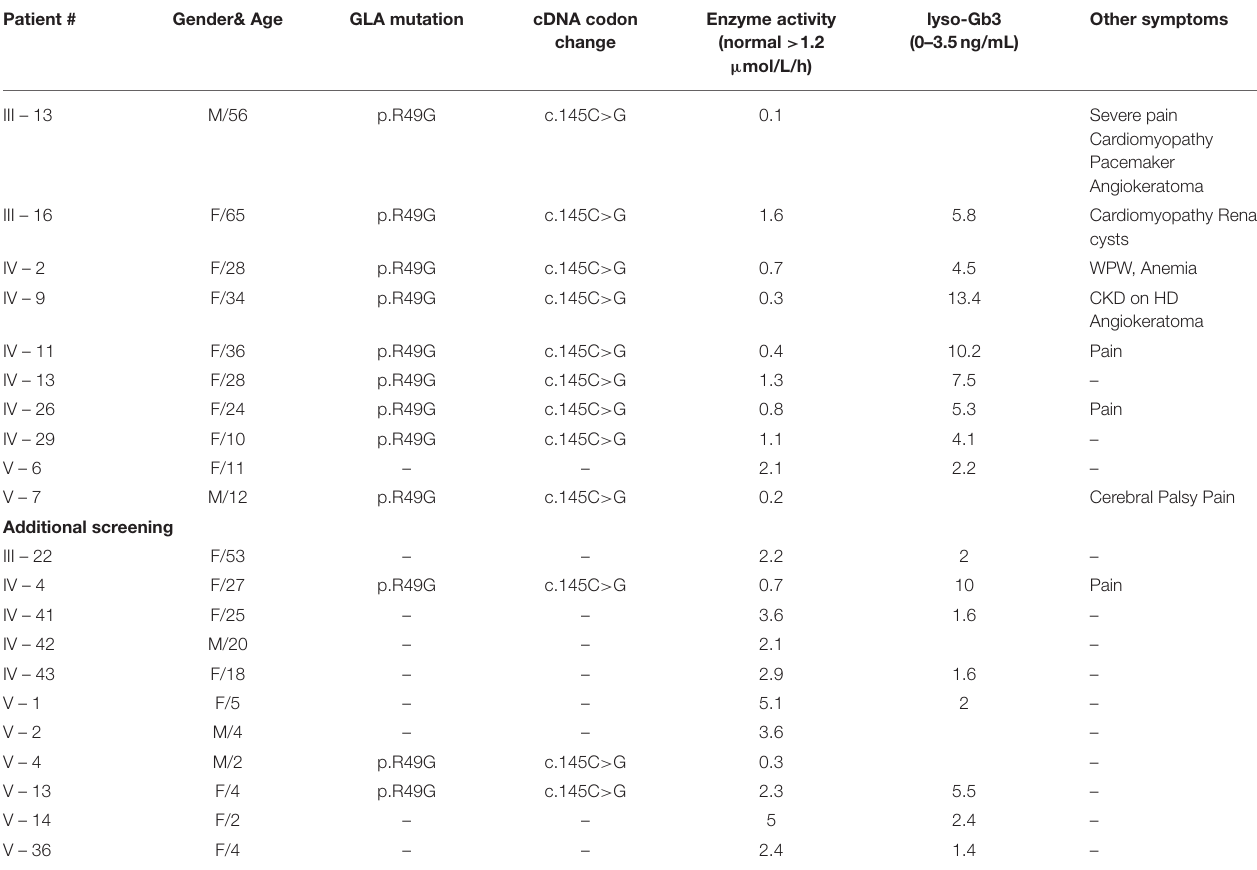
TABLE 2 | GLA diagram of the family